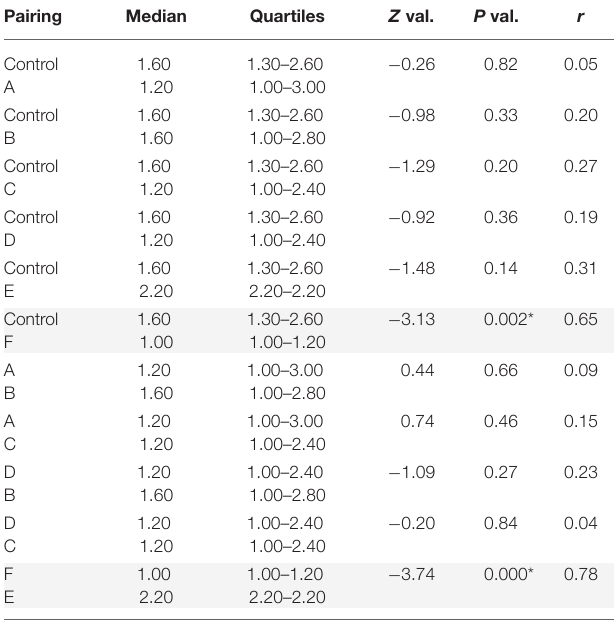
Control, Averaged values from the 1st and 2nd control; A, No Turning Markers and 1 Attractor; B, No Turning Markers and 3 Attractors; C, Turning Markers and 1 Attractor; D, Turning Markers and 3 Attractors; E, No Turning Markers − 2 sets of Attractors; F, Turning Markers − 2 Sets of Attractors. * significant value at p <